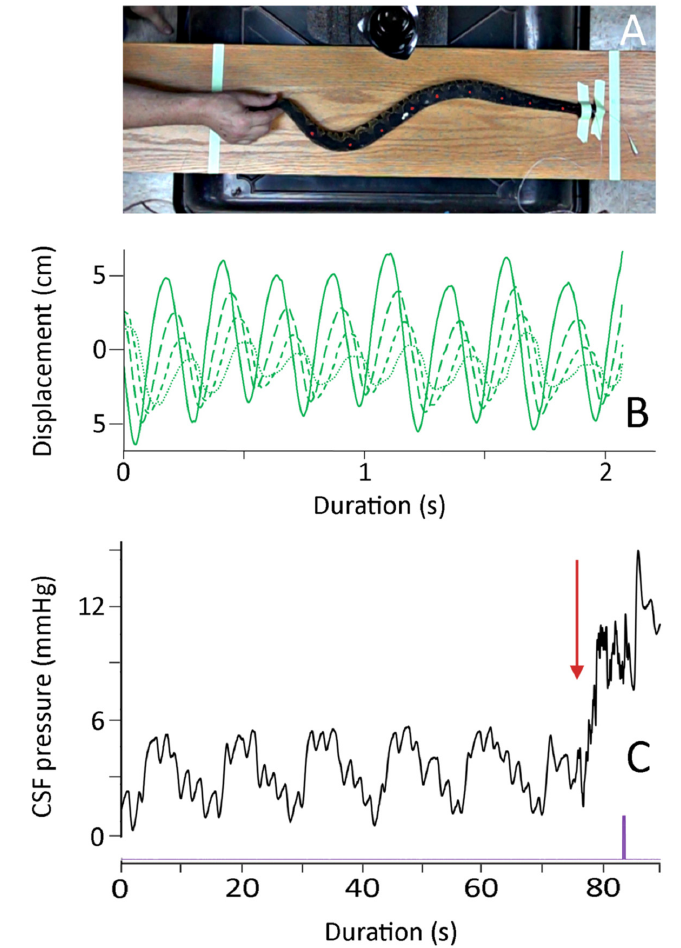
Figure 3. Summary of the manual oscillations. ( A ) Isolated frame from the high-speed digital video; note that the snake’s body is not elevated, the head is secured, and the marker points on the snake’s dorsal surface are clearly evident. ( B ) Kinematic data showing the lateral displacement of four successive body marker points (successive points have finer line dashes); ( C ) Cranial CSF pressure recorded during a manual oscillation trial. Note that the clear pattern of ventilatory (V) and cardiac ( C ) cycles in the CSF pressure is disrupted at the onset of manual oscillations (red arrow). The manual oscillations produced a rapid increase in the baseline CSF pressure, as well as higher-frequency pulsations during the oscillation trials. The purple marker is an integration signal that appeared in all kinematic and pressure records, allowing for the temporal alignment of the data sets.